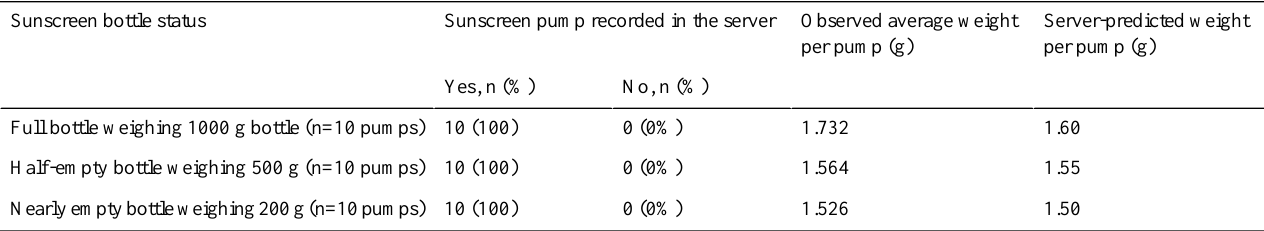
Table 1. Agreement between observed sunscreen usage and server-recorded measurements.